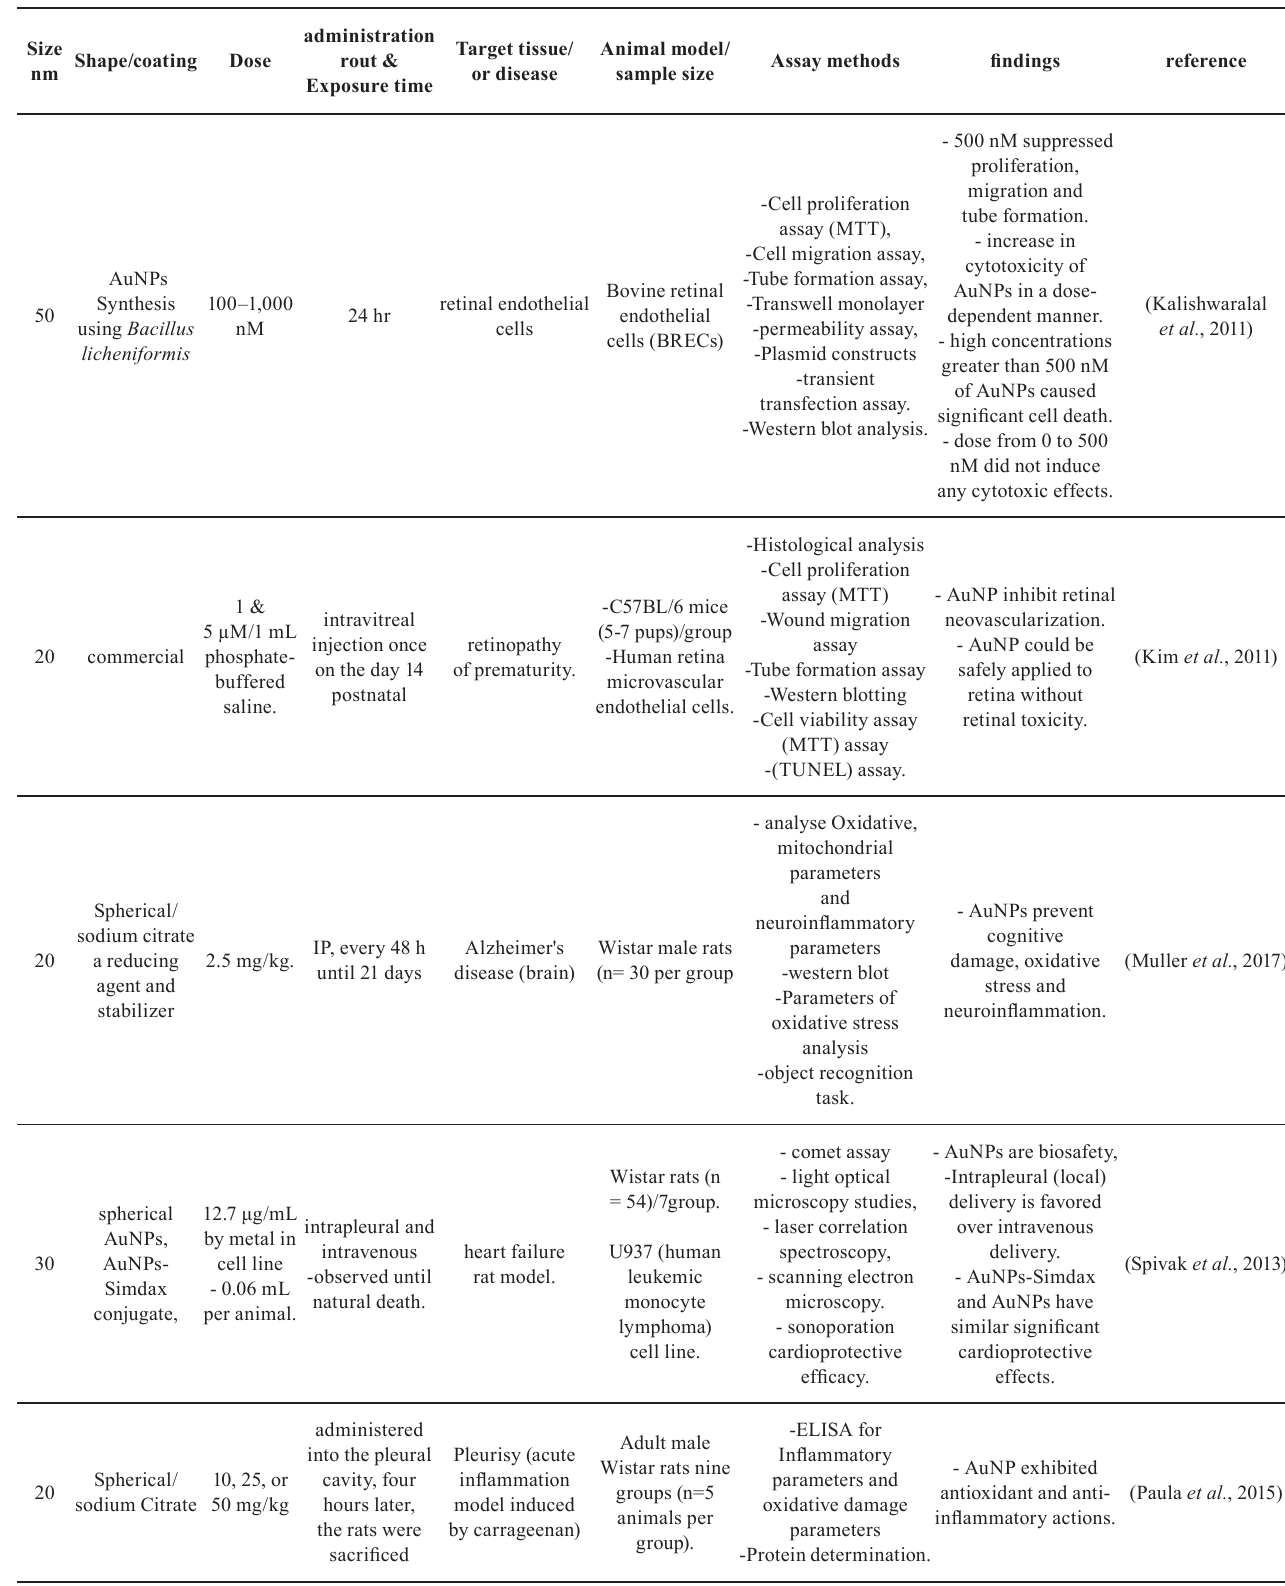
TABLE II – Therapeutic effects of Gold nanoparticles on different disorders